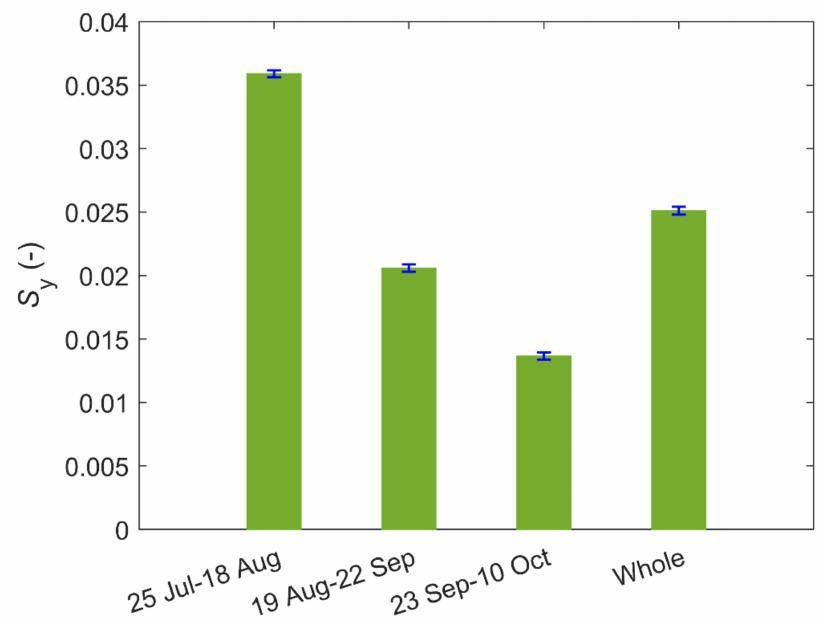
Figure 5. Specific yield ( S y ) calculated by the water balance approach based on different datasets. The standard deviation was calculated using the best 500 values of Sy with minimum RSSs.